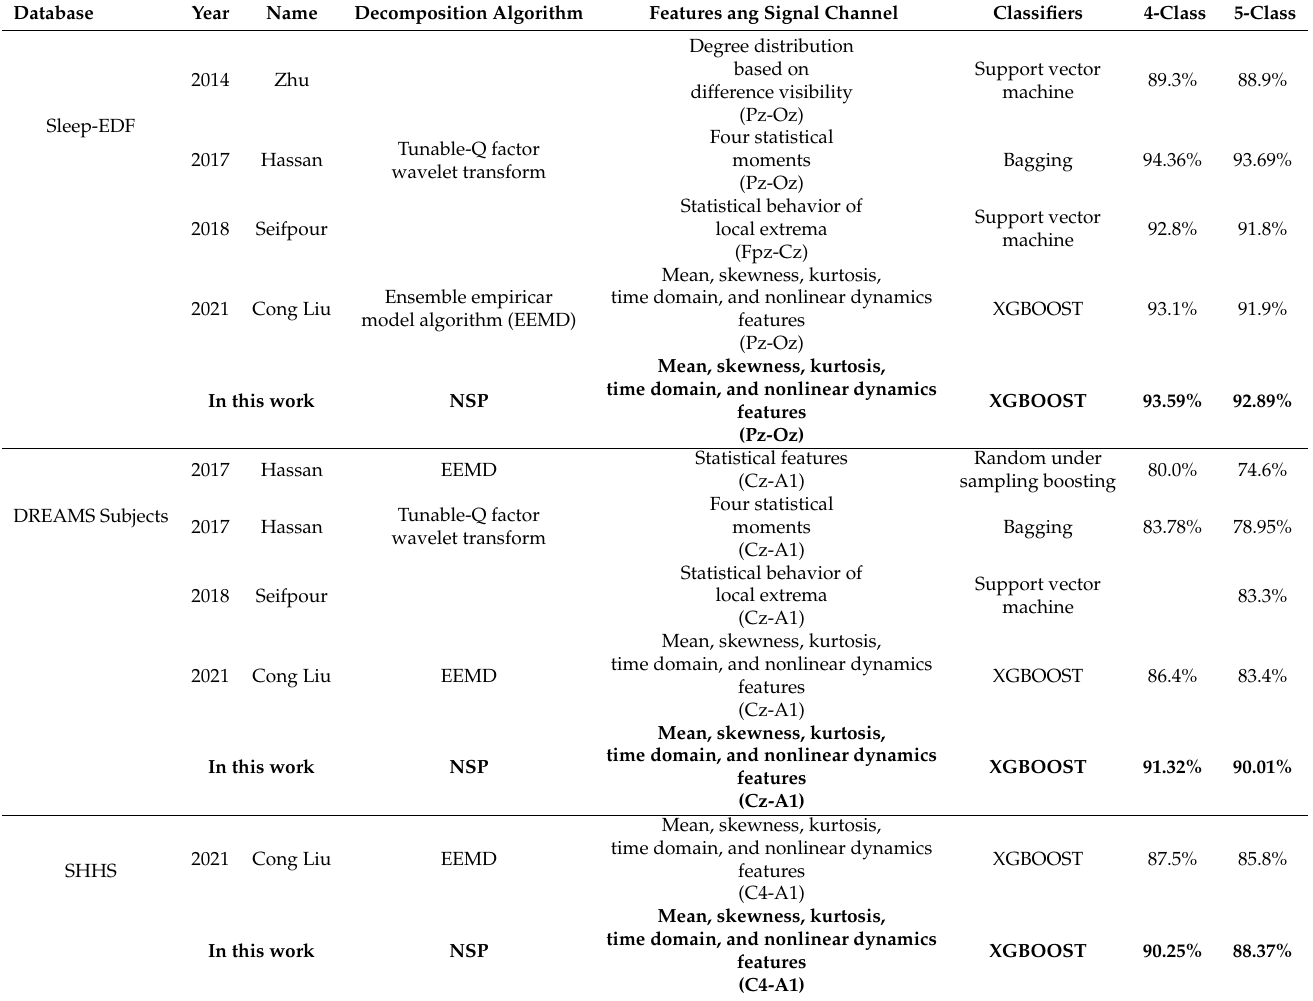
Table 7. Comparison of experimental results.